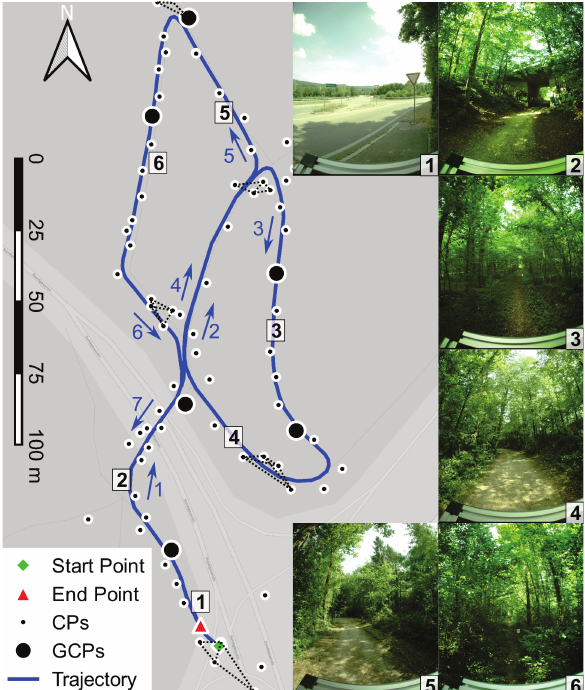
Figure 4. Map from the second test site located in the forest with images showing environmental